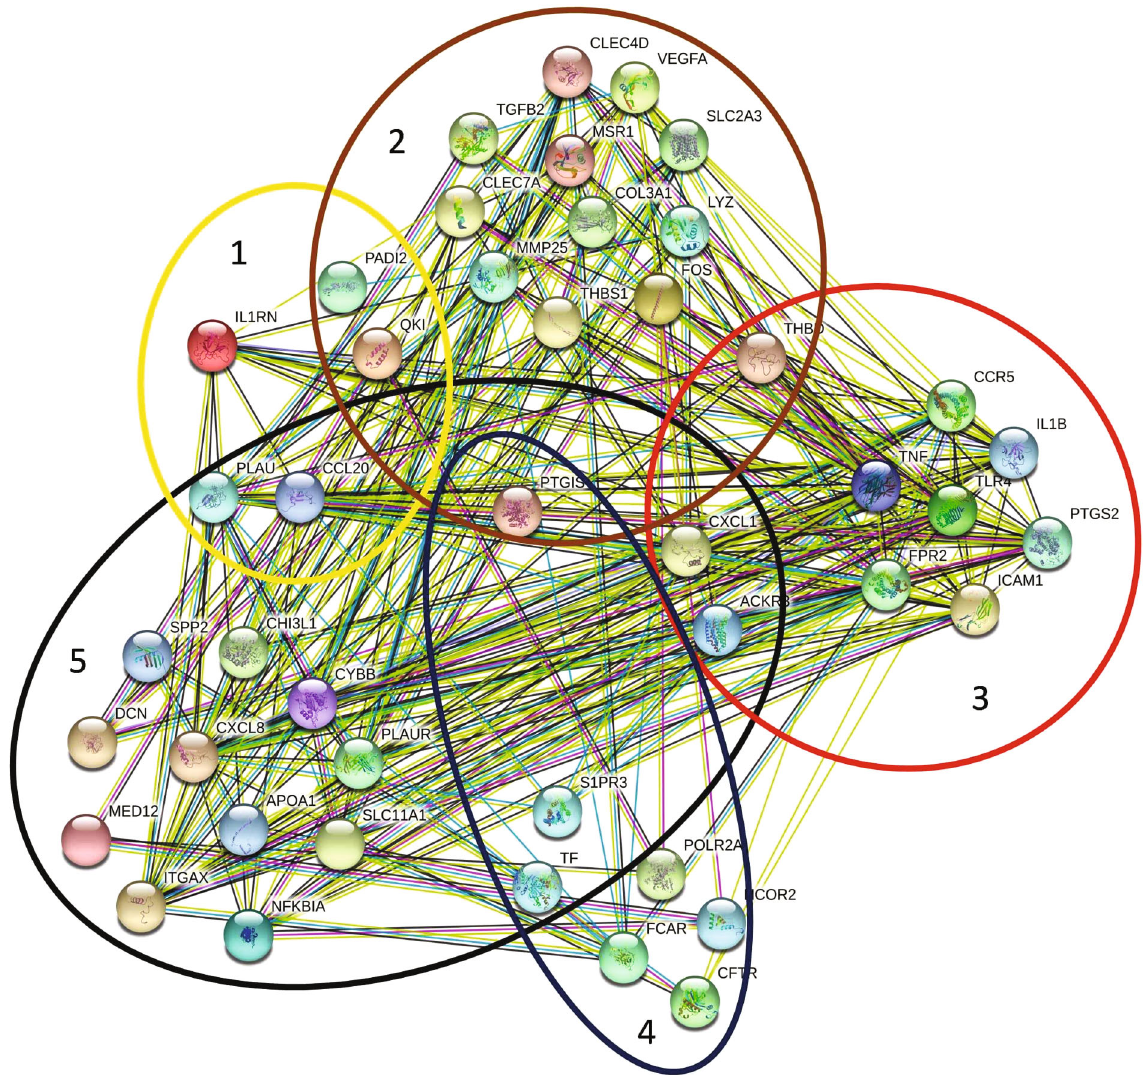
Figure 4: Protein-protein interaction (PPI) network of overlapping DEGs of CVD and its risk factors. The clusters indicate the proteins of the risk factors of CVD (elliptical shape clusters 1, 2, 3, 4, and 5 represent proteins of T2D, obesity, HCL, HTN, and aging, respectively) where some proteins are overlapped in more than one cluster. Table 3: The 10 most signi fi cant hub